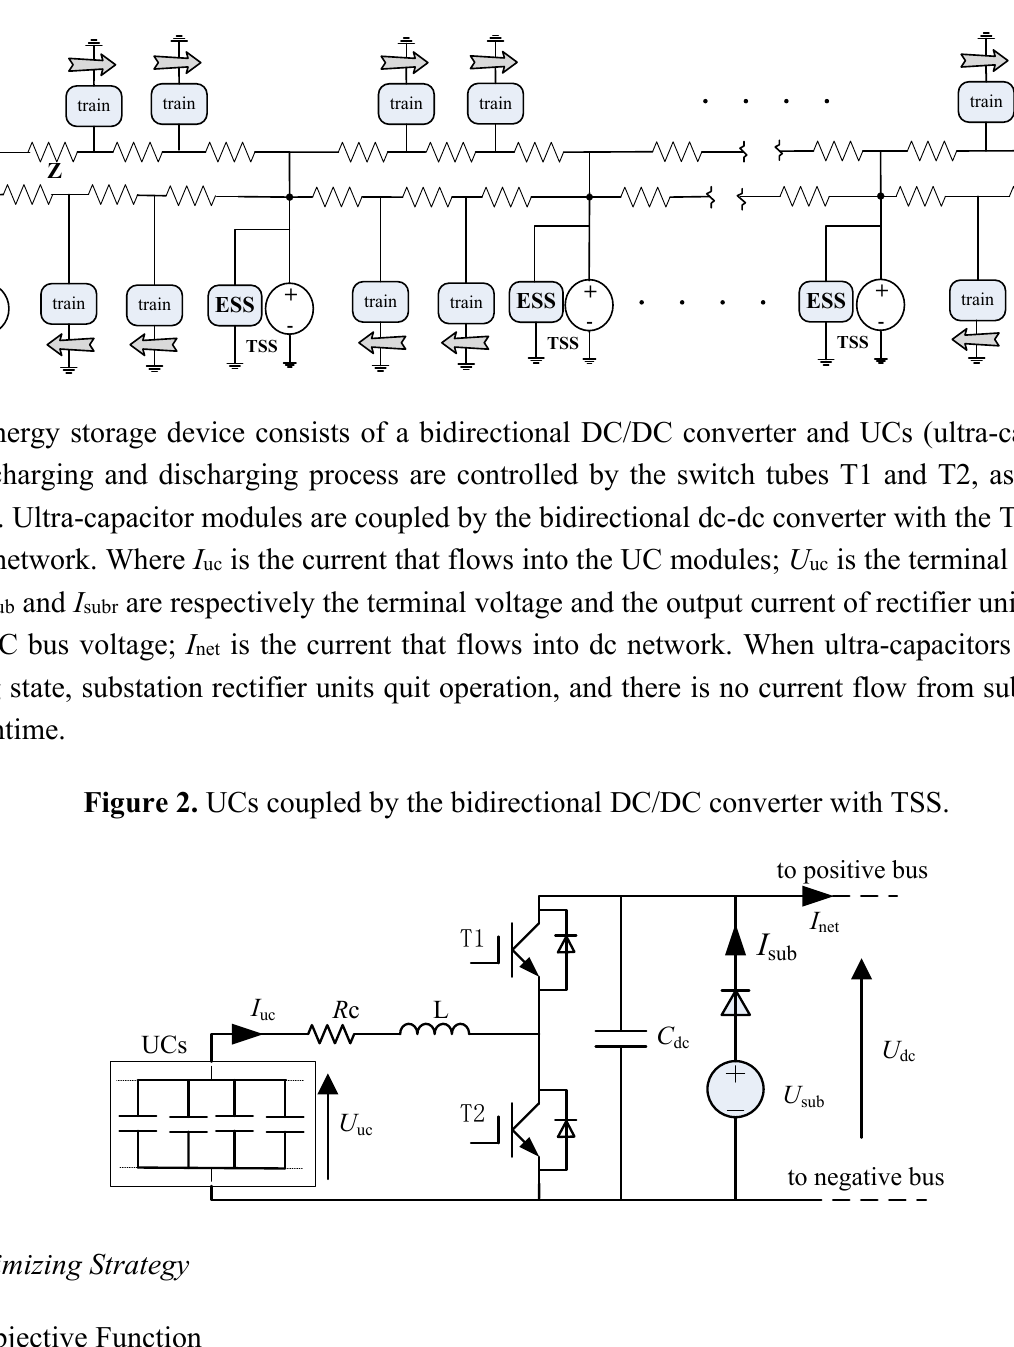
Figure 1. DC traction power supply network of urban rail system.